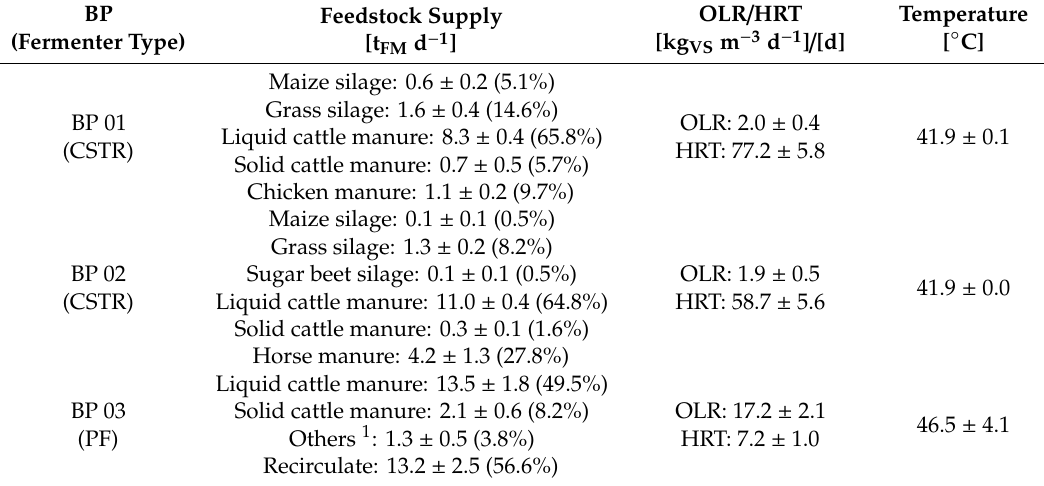
Table 1. Summary of process engineering parameters of the main anaerobic digesters of the analyzed manure-based small biogas plants (BPs). Given are the mean values and their standard deviation as well as in brackets the percentage of each feedstock on the total feedstock amount as median value over a period of one year (one sampling date per month, n = 12). CSTR = continuously stirred tank reactor, PF = plug flow fermenter, FM = fresh mass, OLR = organic loading rate, HRT = hydraulic retention time, VS = volatile solids. For details see Table